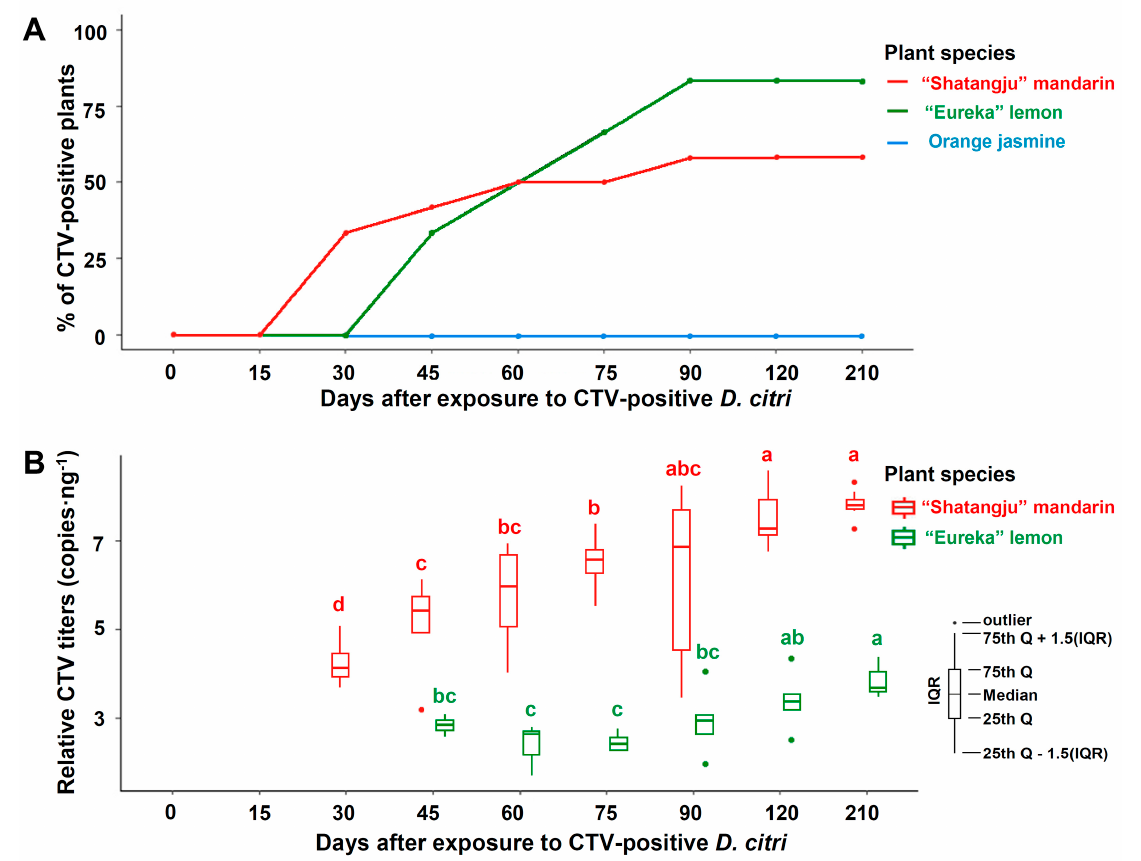
Figure 4. Incidence ( A ) and relative titers ( B ) of Citrus tristeza virus (CTV) in three host species after 5-day inoculation access period (IAP) upon exposure to CTV-positive Diaphorina citri . Values in ( B ) are log-transformed copy numbers of the CTV p20 gene from plants/ng of total citrus cDNA. Non-overlapping error bars between the box plots indicate statistical significance. The same letter indicates no significant difference by non-parametric Kruskal–Wallis. Legend: “Shatangju” mandarin: C itrus reticulata Blanco “Shatangju”; “Eureka” lemon: Citrus × limon var. limon (L.) Burm. f.; Orange jasmine: Murraya paniculata (L.) Jack.; Q = percentile; IQR = interquartile range; 0 days: testing the plants immediately after 5-day IAP by CTV-positive D. citri